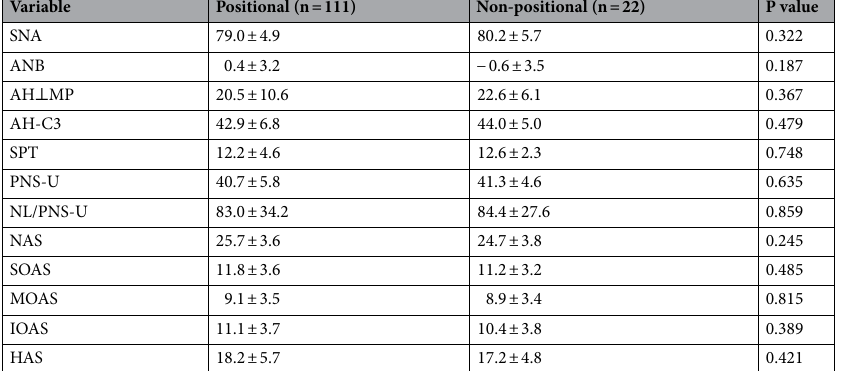
Table 4. Cephalometric parameters according to positional dependency. SNA, smaller angle which is formed by sella (S), nasion (N), and A point; ANB, smaller angle which is formed by A point, nasion (N), and B point; AH ⊥ MP, the perpendicular distance between AH and Go-Me line; AH-C3, the distance between AH and the third vertebra; SPT, maximum width of soft palate which is perpendicular to PNS-U line; PNS-U, the distance between PNS and U; NL/PNS-U, smaller angle between ANS-Pm line and PNS-U line; NAS, nasal airway space; SOAS, superior oral airway space; MOAS, middle oral airway space; IOAS, inferior oral airway space; HAS, hyoid airway space. Results were obtained from independent T test: mean ± SD.